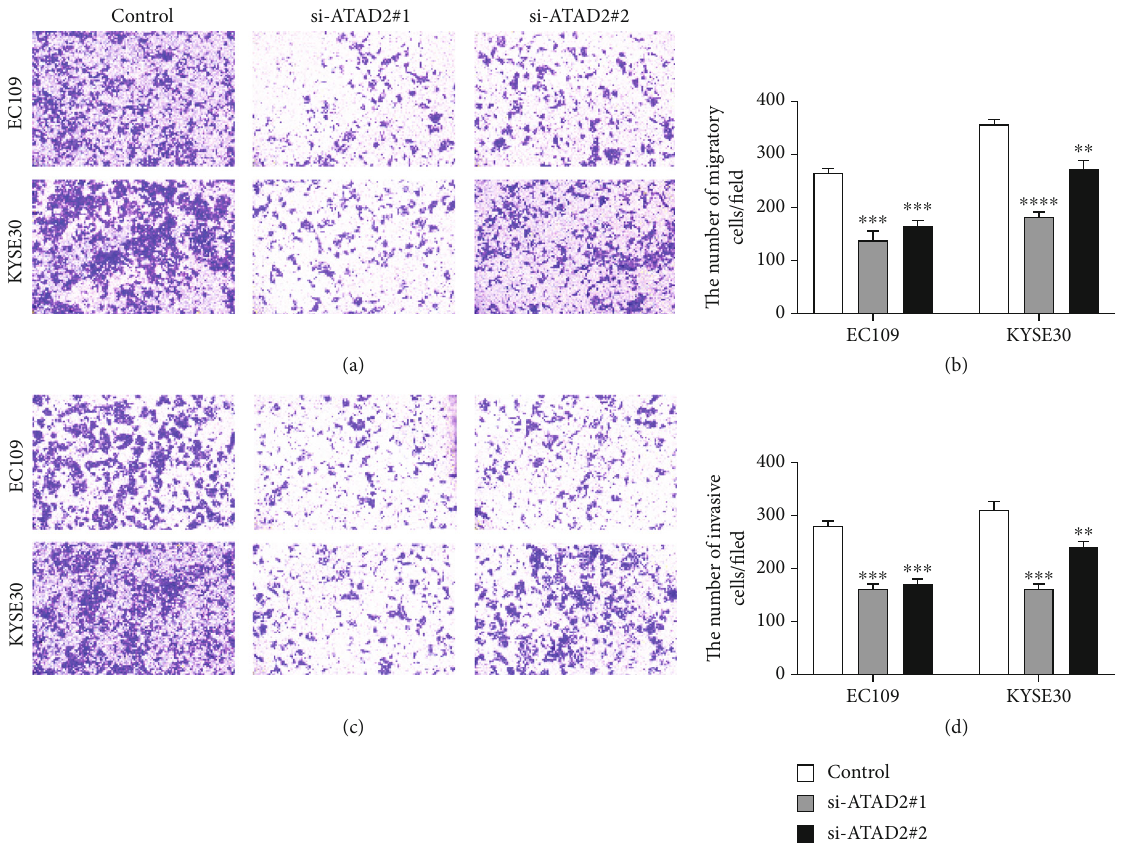
Figure 4: Migration and invasion assay in ESCC cell lines. (a, c) Transwell assay was performed to detect the e ff ect of ATAD2 on the (a) migration and (c) invasion abilities in EC109 and KYSE30 cell lines. (b, d) ATAD2 knockdown inhibited the migratory and invasive abilities of EC109 and KYSE30 cells. ∗∗ P < 0 : 01 and ∗∗∗ P < 0 : 001